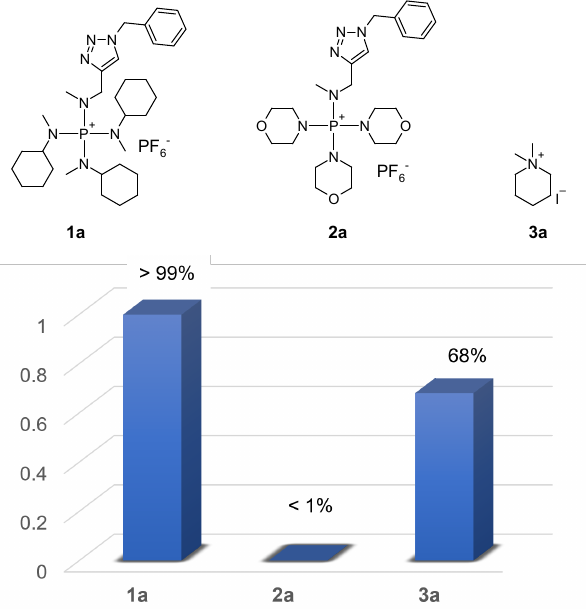
Figure 1. Percentage remaining of model compounds in 2M KOH in CD 3 OH/DMSO (3/1, v / v ) at 80°C after 30 days.